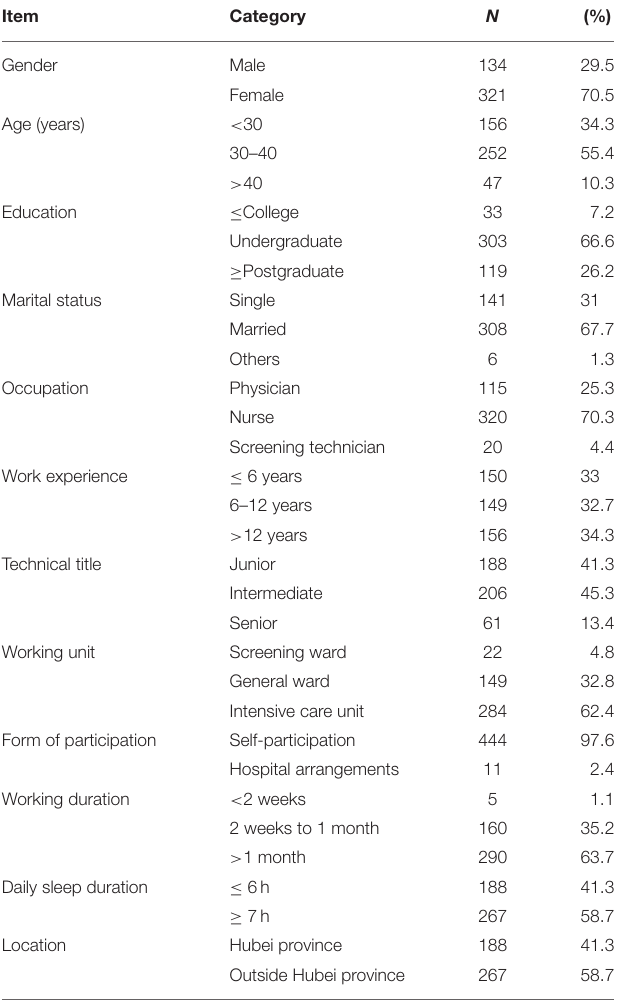
TABLE 1 | Demographic and job characteristics of frontline medical staff fighting against